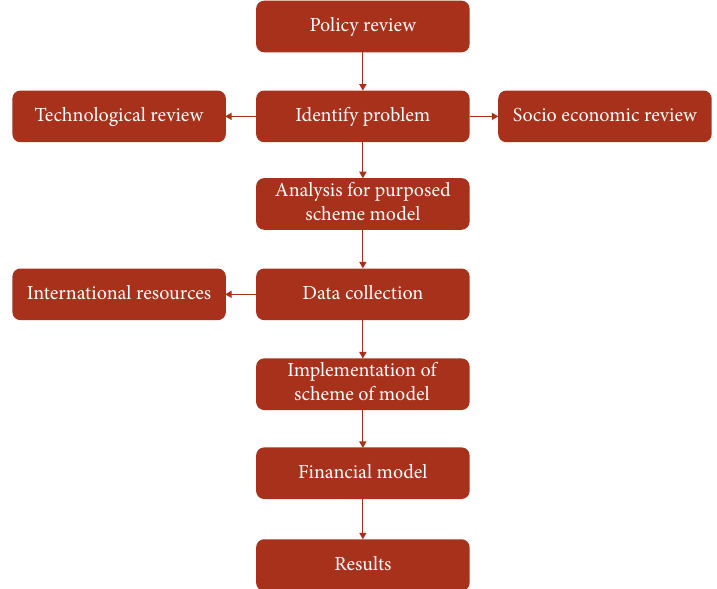
Figure 2: Experimental procedure [25].